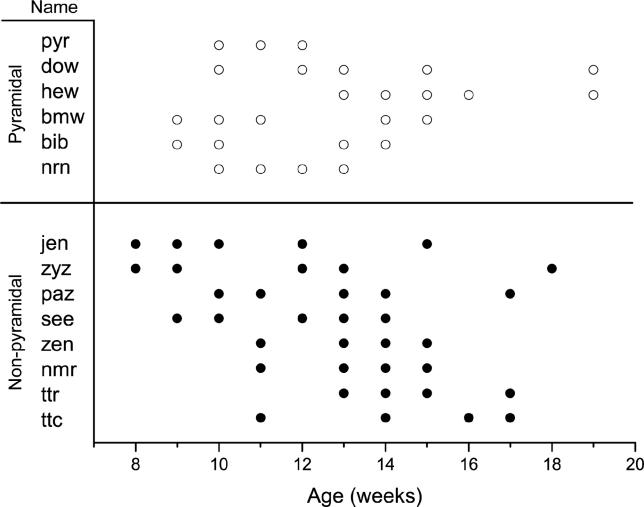
Summary of Imaging Sessions Displayed by AgeEach neuron was named by an arbitrary three-letter code. Empty circles represent pyramidal neuron-imaging sessions, and filled circles represent non-pyramidal neuron-imaging sessions.